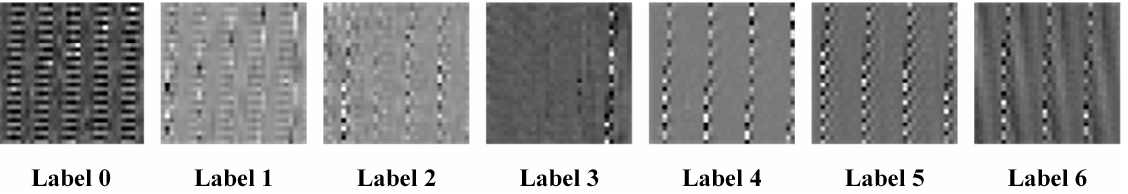
Figure 11. Grayscale images of seven experimental signals.